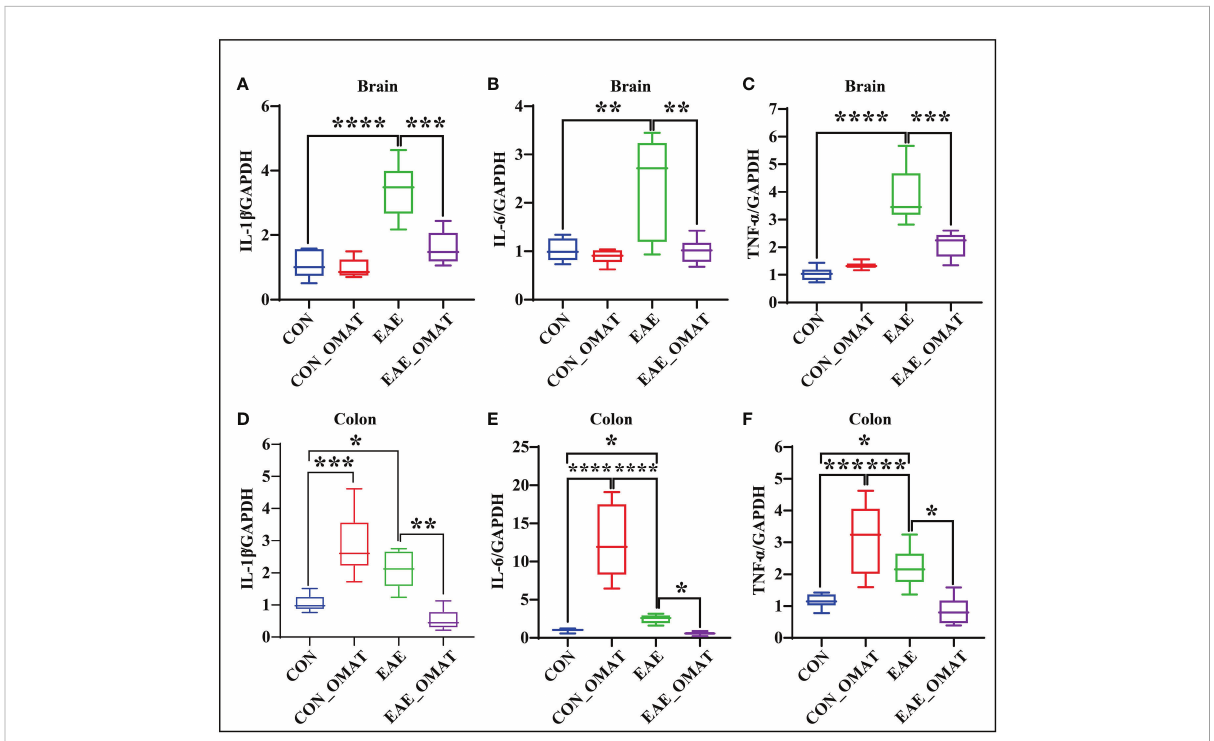
FIGURE 8 Effect of oxymatrine on the expression of pro-in fl ammatory cytokines in the brains and colons of EAE mice (n = 6 in each group). Results of RT- qPCR analysis showing a decrease in the mRNA expression of IL-1 b (A, D) , IL-6 (B, E) , and TNF- a (C, F) in brain and colon samples of EAE mice after OMAT treatment. Data are expressed as the mean ± SD and statistical differences are represented by *, P < 0.05, **, P < 0.01, ***, P < 0.001, and ****, P < 0.0001 based on LSD-t